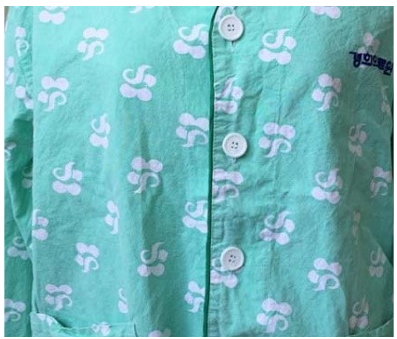
Figure 2. Block repeat pattern for patient clothing .